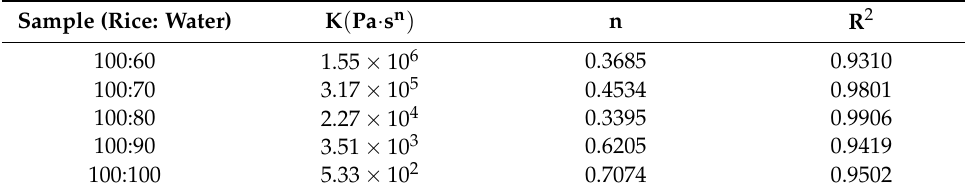
Figure 5. The apparent viscosity of rice paste at different mixture ratios. Table 2. Fitted coefficient values of the power-law model of the rice paste.